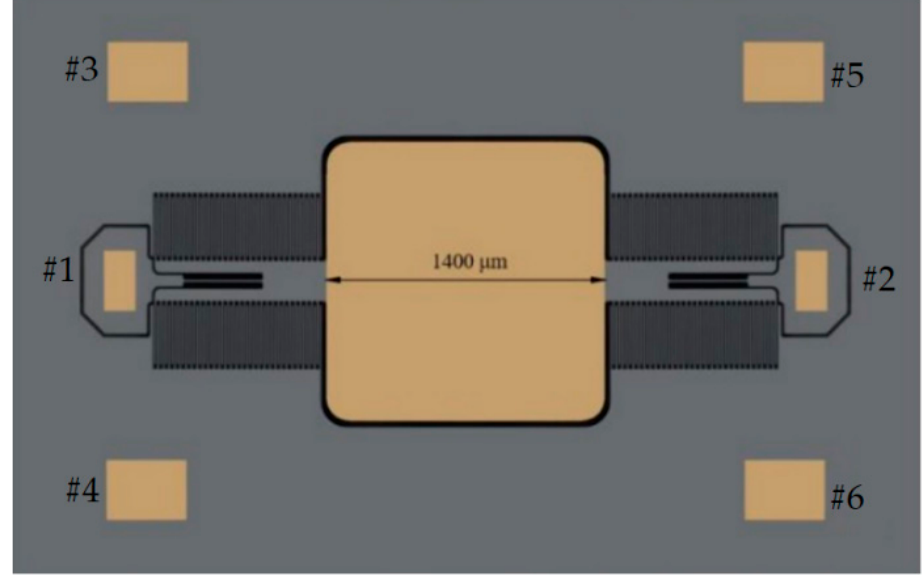
Figure 3. A top-view photo of the MEMS micromirror.